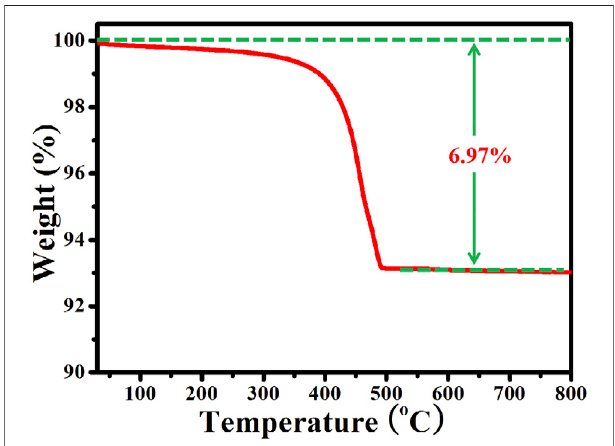
FIGURE 6 | TG curve of Ag/ZnO@N-carbon under air atmosphere.